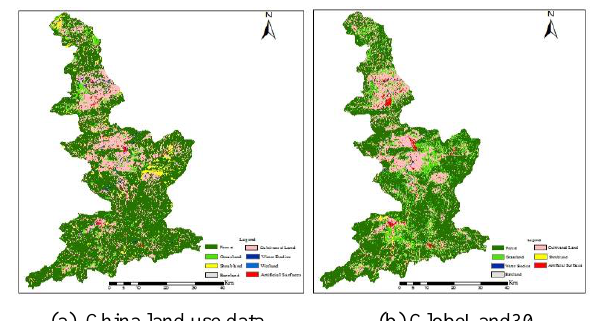
Figure 3. Land cover reclassification images in northern